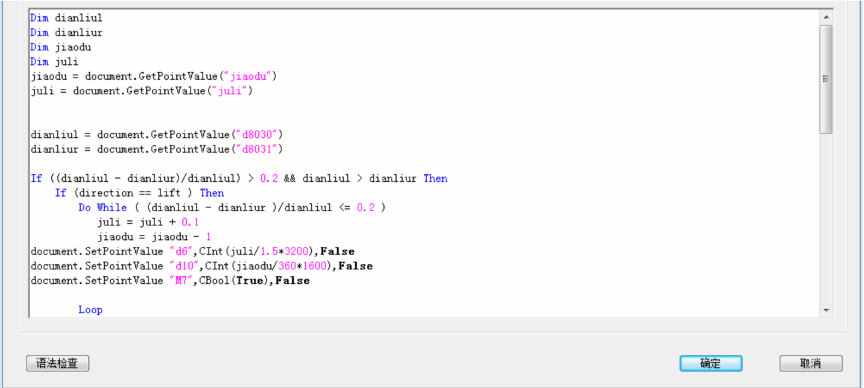
Figure 13. Design window of cycle scripting.